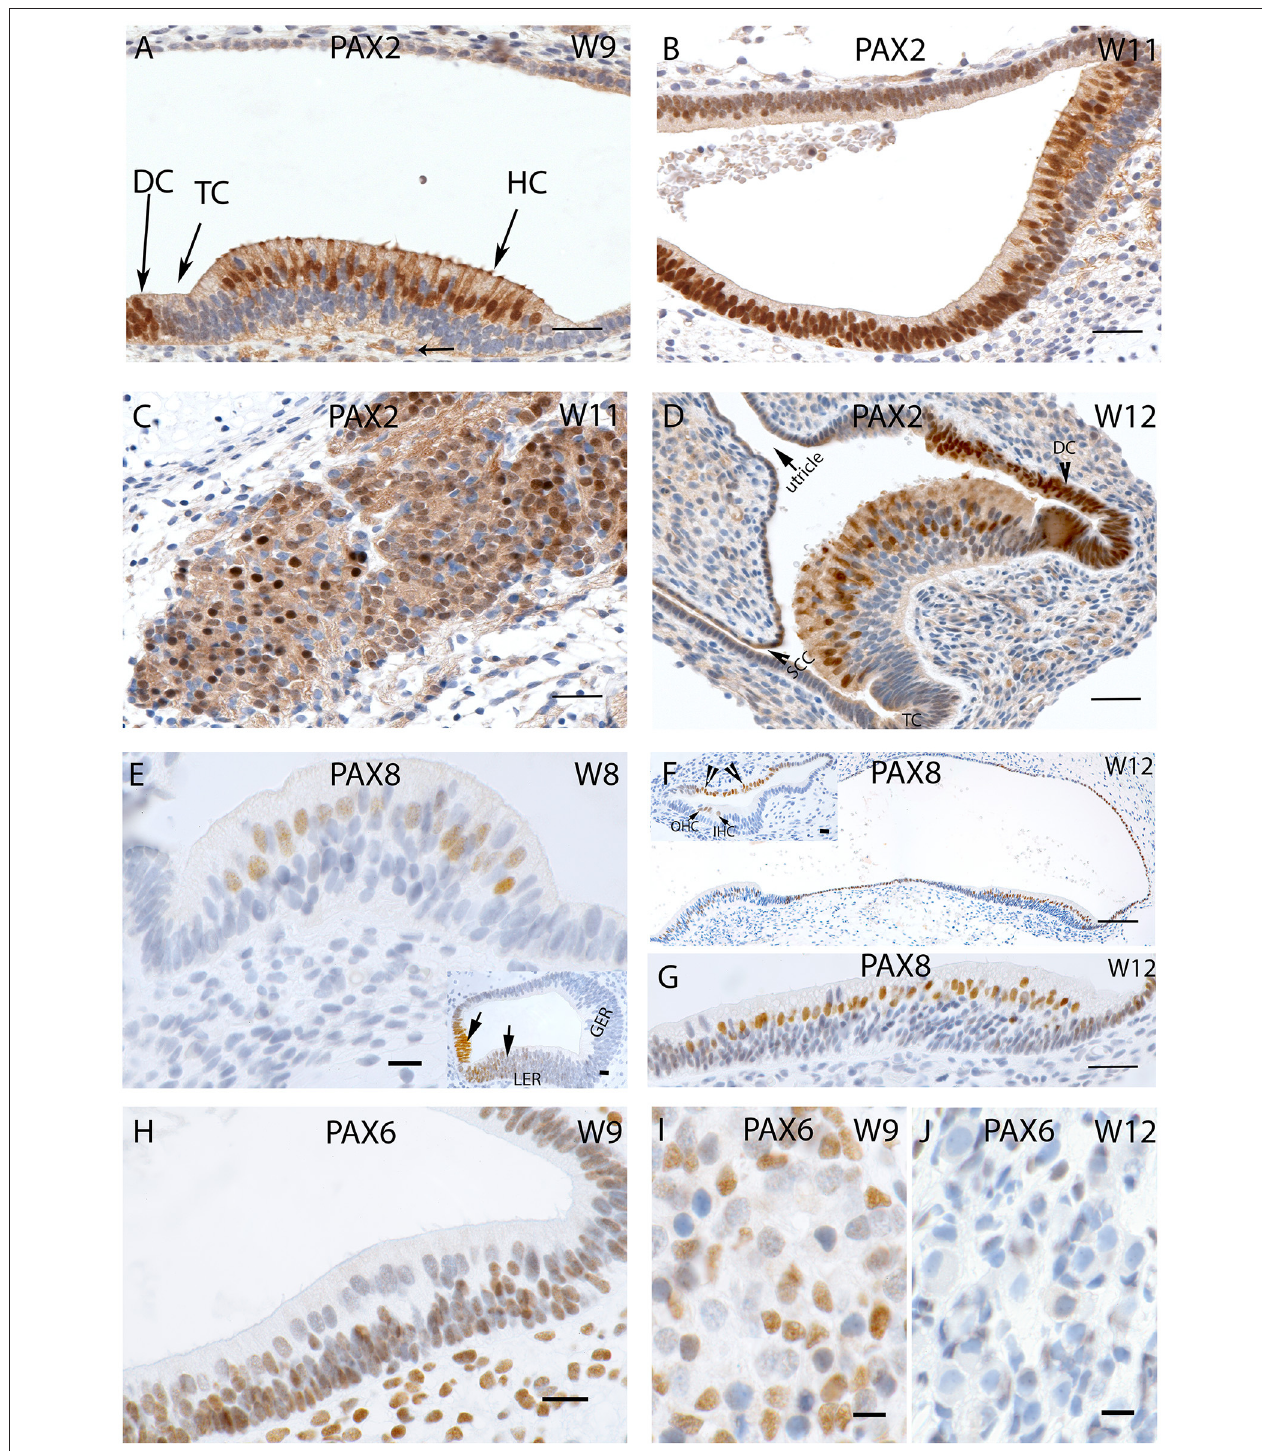
FIGURE 5 | (A) PAX2 expression in a crista ampullaris at W9 with staining apparent in the nuclei and cytoplasm of the hair cells as well in the DC’s (B) PAX2 exhibits intense cytoplasmic expression in the saccule and epithelial cells of the membranous labyrinth. (C) Intense and specific staining is apparent at the VG neurons at W11 with different intensities in cell nuclei. (D) PAX2 expression in an ampullary crest at W12, hair cells and the DC are positive for this marker. However, the TC is negative. There is a gradient of lower staining toward the periphery. The semi-circular canals side (SCC) (arrow head) shows less immunoreactivity compared the utricular side of the crest. (E) PAX8 immunostaining is visible in the otic epithelia among the future hair cells of the cristae ampullaris at W8. ( E , inset) the staining for PAX8 is also visible